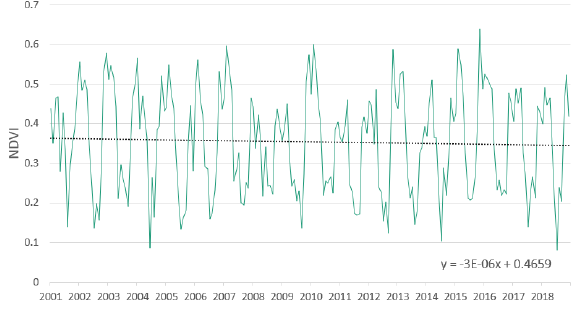
Figure 12. Monthly Average NDVI Values of Busuanga, Philippines from MODIS (2001-2018)